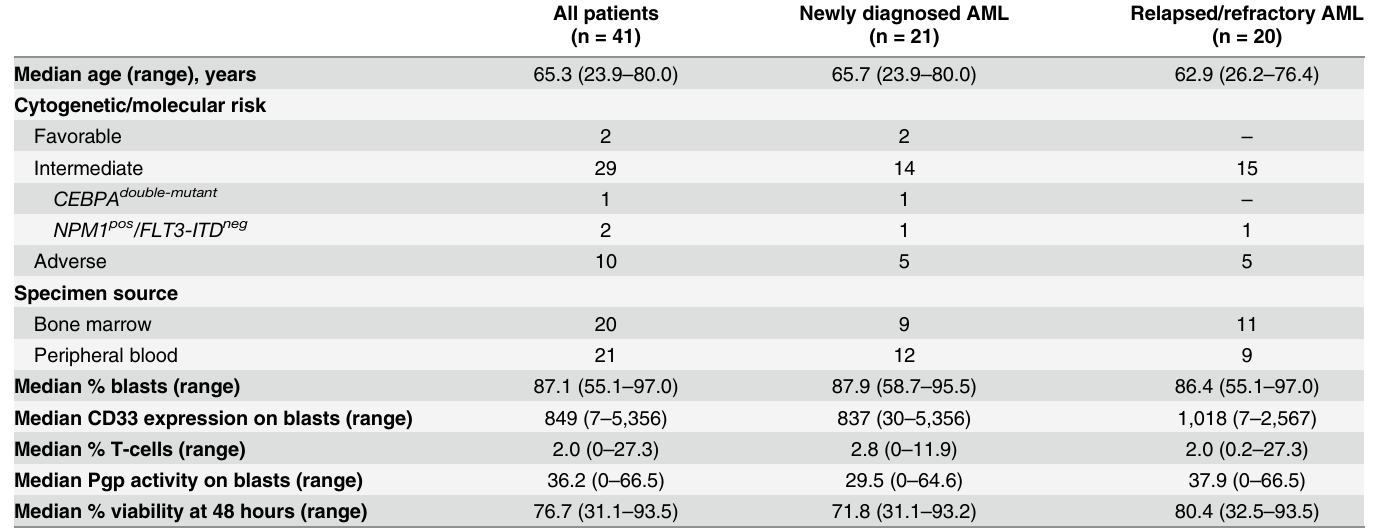
Table 1. Patient Characteristics.